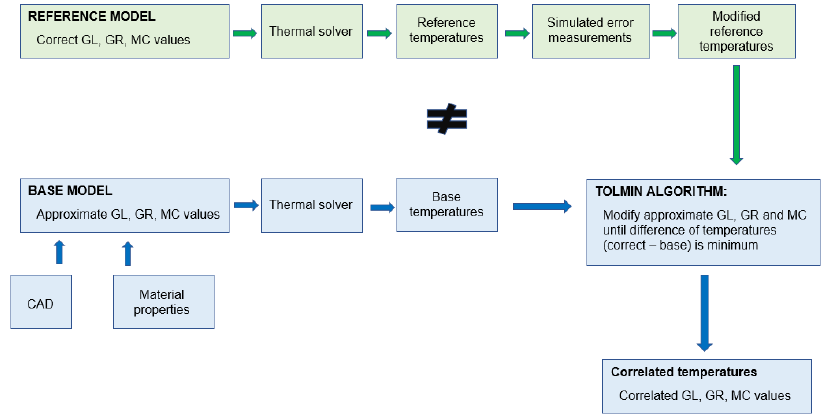
Figure 1. Graphical description of the methodology.